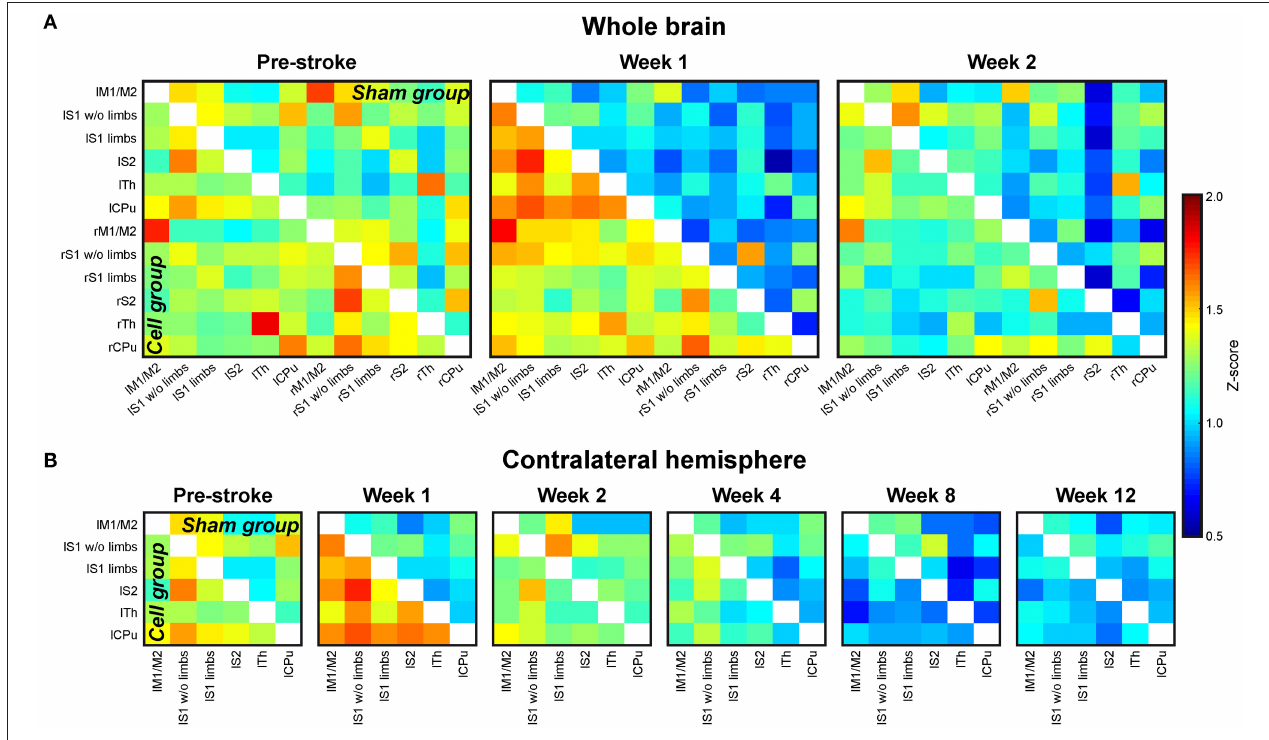
FIGURE 6 | Cross-correlation z-score matrices of sensorimotor functional connectivity. (A) Z-score matrices of the whole mouse brain sensorimotor functional network before (pre-stroke) stroke induction and at 1 and 2 weeks after stroke induction. Directly following stroke, correlation strengths are decreased in the sham group (stroke without cell treatment; upper matrix triangle). The effect is strongest for the ipsilateral (right) hemisphere. In animals with stroke and stem cell implantation into the cortex adjacent to the ischemic lesion (cell group; lower matrix triangle), no reduction in the functional network is observed. (B) Z-score matrices of the sensorimotor networks on the contralateral hemisphere during the whole 12 weeks of observation. Similar to the ischemic hemisphere, but less pronounced, the sham group shows a connectivity decrease, continuously becoming more severe during the 12 weeks. In the stem cell group, the implantation stabilizes the connectivity strength still at week 2. Then, the functional connectivity continually decreases, approximating the lower value matrices of the sham group between week 8 and 12. “l” prefix, left hemisphere; “r” prefix, right hemisphere; M1/M2, primary/secondary motor cortex; S1w/o limbs, S1 somatosensory cortex without limb representation area; S1 limbs, limb representation area of S1; S2, secondary somatosensory cortex; Th, thalamus; CPu, caudate putamen. Reproduced with permission from Green et al.